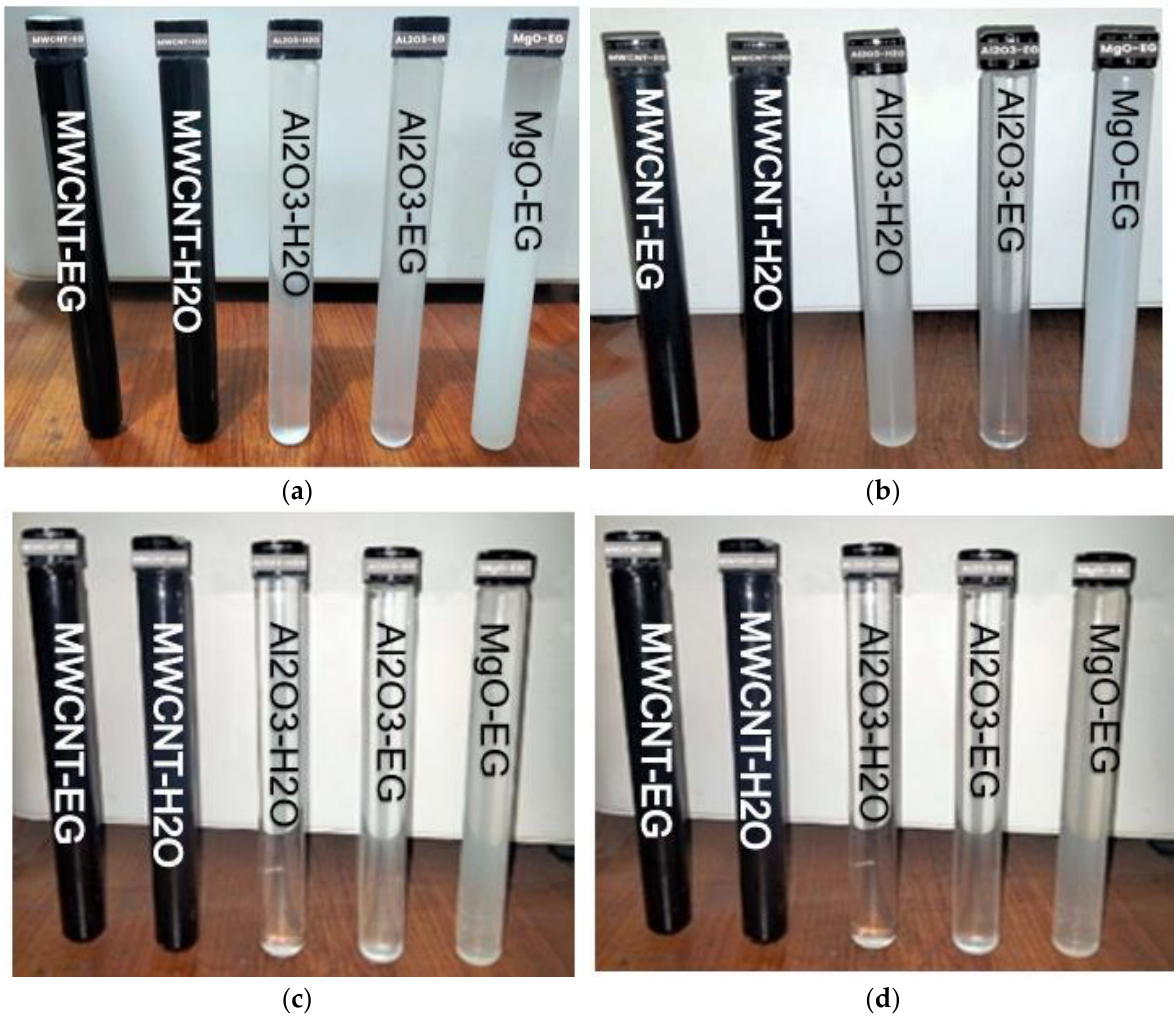
Figure 4. Visual stability with 0.075 vol% ( a ) after preparation, ( b ) after 20 h, ( c ) after 40 h, ( d ) after 60 h.